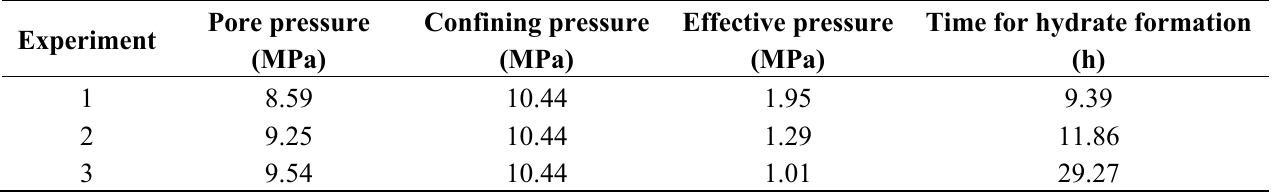
Table 3. Summary of the effect of pore-pressure/consolidation on the kinetics of methane hydrate formation Experiments 1–3 at a constant confining pressure and cooling